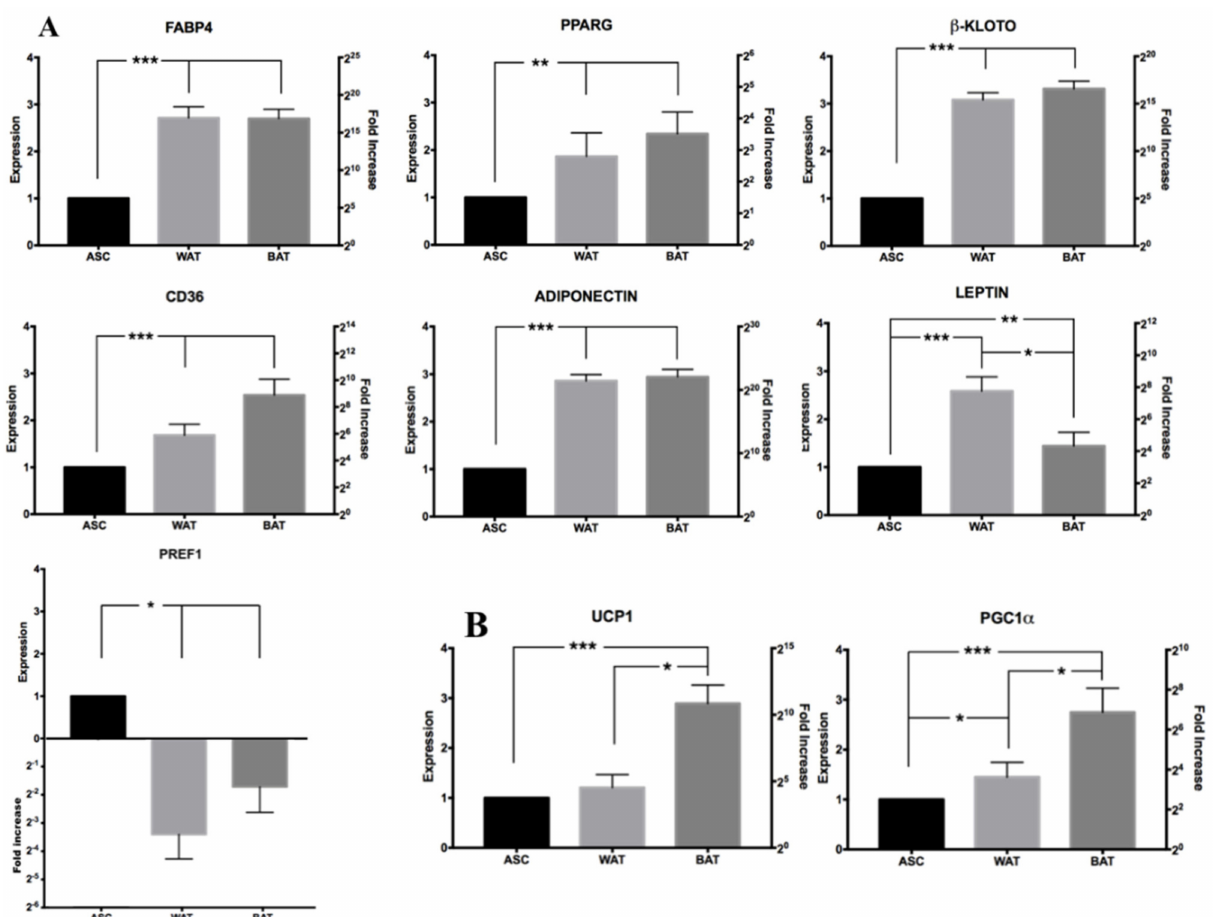
Figure 9. RT-qPCR analysis of different genes involved in WAT and BAT differentiation. ( A ) Expression of seven common genes involved in adipogenesis regulation. ( B ) Expression of the two main common genes involved in the maturation of brown/beige adipose tissue. Data represent the mean fold-increase expression in different medium ± SD versus ASC. Gene expression is normalized to undifferentiated ASC (indicated on the “Expression” y -axis), the different expression of genes in WAT or BAT differentiation medium are indicated on the “Fold Increase” y -axis on the logarithmic scale. To detect a significant difference, a one-way ANOVA was performed for each gene. * p -value < 0.05; ** p -value < 0.01 *** p -value <